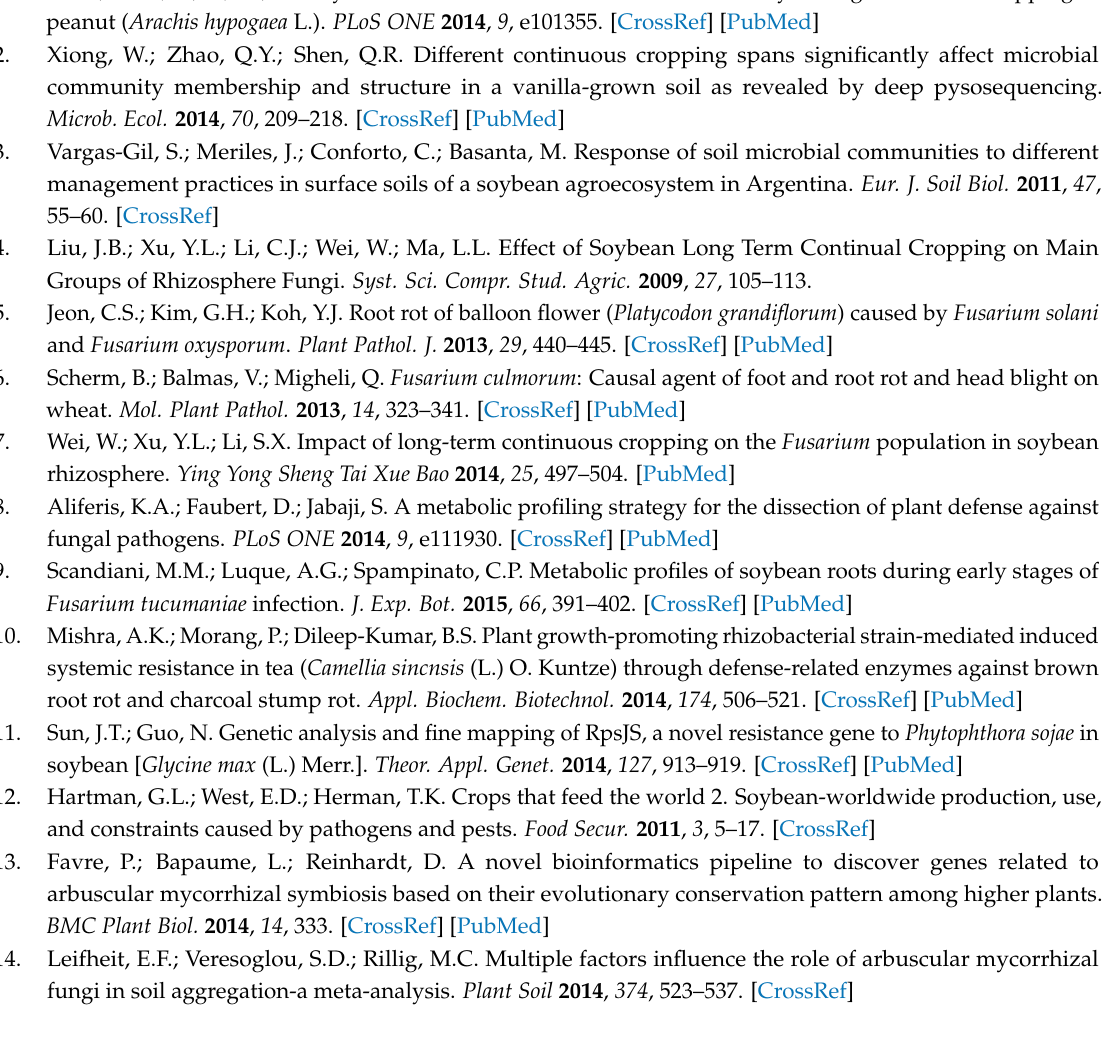
continuously-cropped year soil, Figure S4: Compared the root tissue metabolome of non-inoculated F. mosseae to inoculated F. mosseae in HN48 under different year of soybean continuously-cropped soils by potted-experiments, Figure S5: Compared the root tissue metabolome of non-inoculated F. mosseae to inoculated F. mosseae in HN66 under different year of soybean continuously-cropped soils by potted-experiments, Figure S6: Compared the root exudates of non-inoculated F. mosseae to inoculated F. mosseae in HN48 under different year of soybean continuously-cropped soils by potted-experiments, Figure S7: Compared the root exudates of non-inoculated F. mosseae to inoculated F. mosseae in HN66 under different year of soybean continuously-cropped soils by potted-experiments, Table S1: The relative abundance (%) of differentially metabolites from HN48 root tissue under different continuous-cropped year soil in potted-experiments, Table S2: The relative abundance (%) of differentially metabolites from HN66 root tissue under different continuous-cropped year soil in potted-experiments, Table S3: The relative abundance (%) of differentially metabolites from HN48 root exudates under different continuous-cropped year soil in potted-experiments, Table S4: The relative abundance (%) of differentially metabolites from HN66 root exudates under different continuous-cropped year soil in